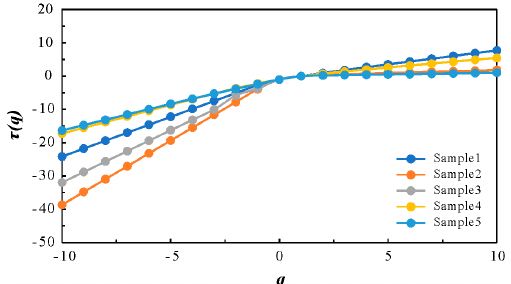
Figure 8. Generalized mass exponent τ (q) versus variable q.